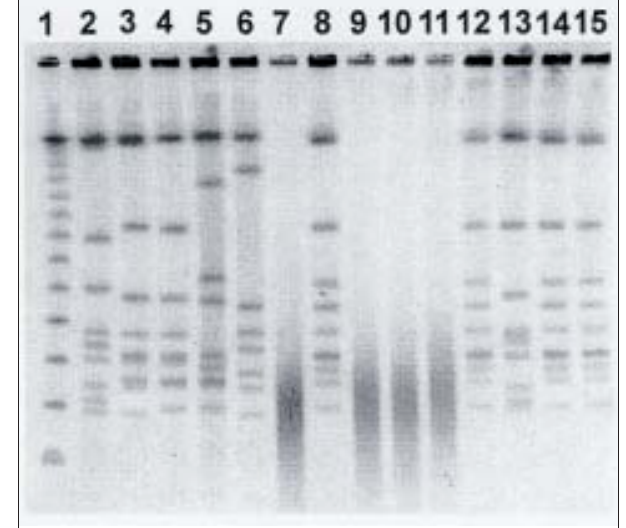
Figure 4) Pulsed field gel electrophoresis profiles (PFGE). From the 57 isolates available for analysis, there were 21 distinct PFGE profiles. Thismicrographshowssixofthe21PFGEprofiles.Lane1containsthe PFGE markers, lanes 2 to 15 contain samples of Clostridium difficile DNA digested with Sma I. Lanes 7,9,10,11 contain isolates that could not be analyzed because the DNA was degraded and did not produce banding patterns (despite several attempts). The other samples in- cluded stool isolate patient 29 (lane 2); stool isolate patient 32 (lane 3); bed pan sprayer isolate patient 35 (lane 4); stool isolate pa- tient 41 (lane 5); stool isolate patient 41 (lane 6); stool isolate patient 55 (lane 8); stool isolate, patient 52 (lane 12); sprayer isolate patient 52 (lane 13); stool isolate patient 52 (lane 14); and stool isolate pa- tient 52 (lane